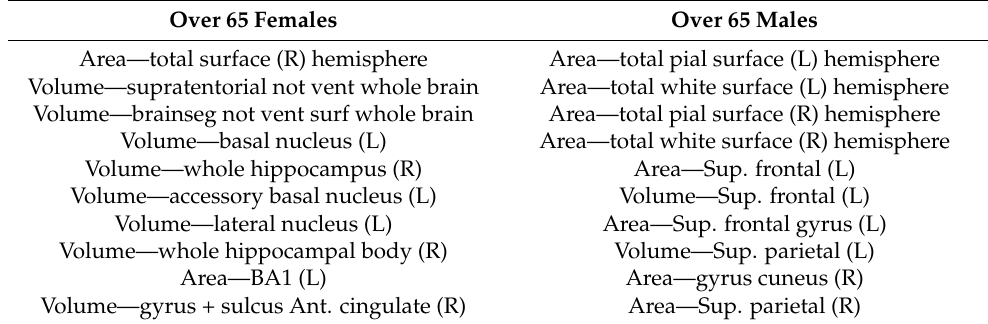
Table 5. Top 10 image-derived phenotypes for classifying the UKB participants into APOE4 carriers or APOE 3/3 controls in males and females aged over 65 years. Over 65